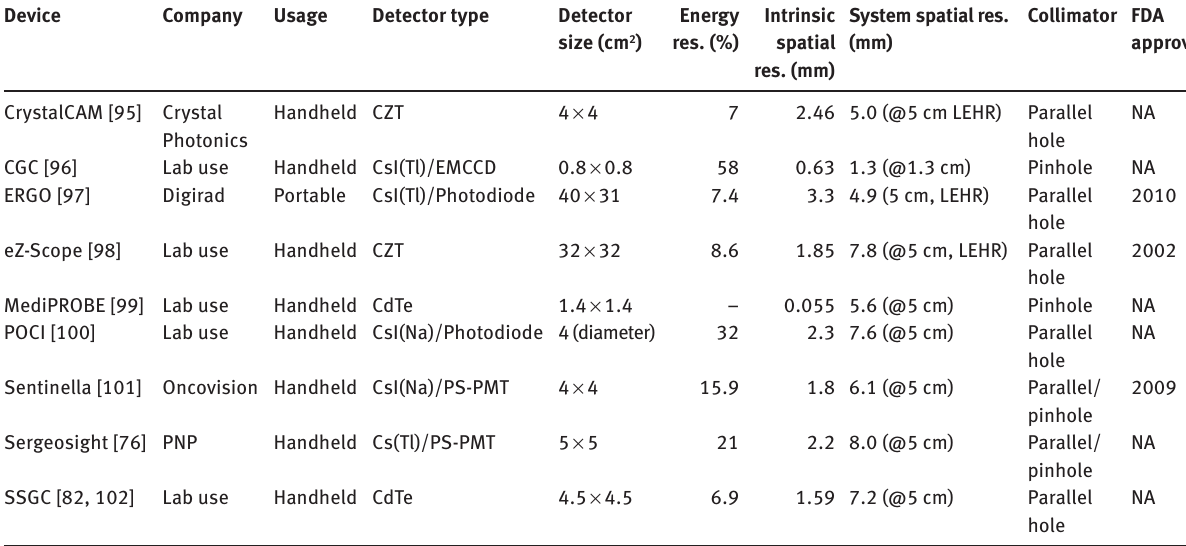
Table 2: Clinically reported intraoperative gamma cameras.